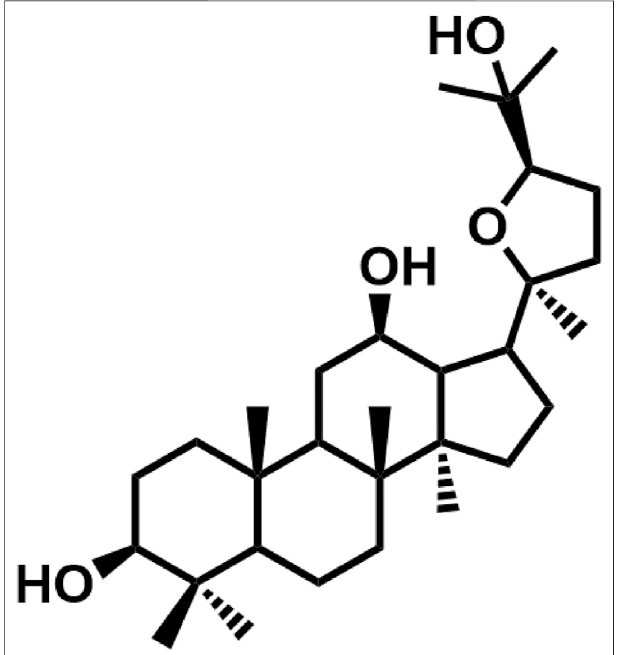
FIGURE 1 | Chemical structure of